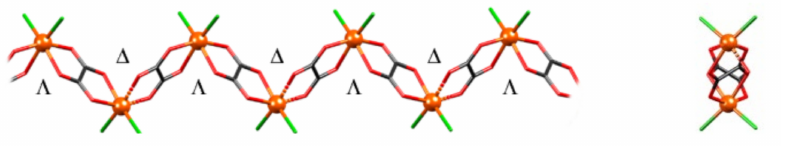
Figure 3. The [FeCl 2 (C 2 O 4 )] nn − chains in polymer 1 with indicated configuration of stereogenic iron(III) centers. A side-view of the chains is shown on the left, and a view along a chain is shown on the